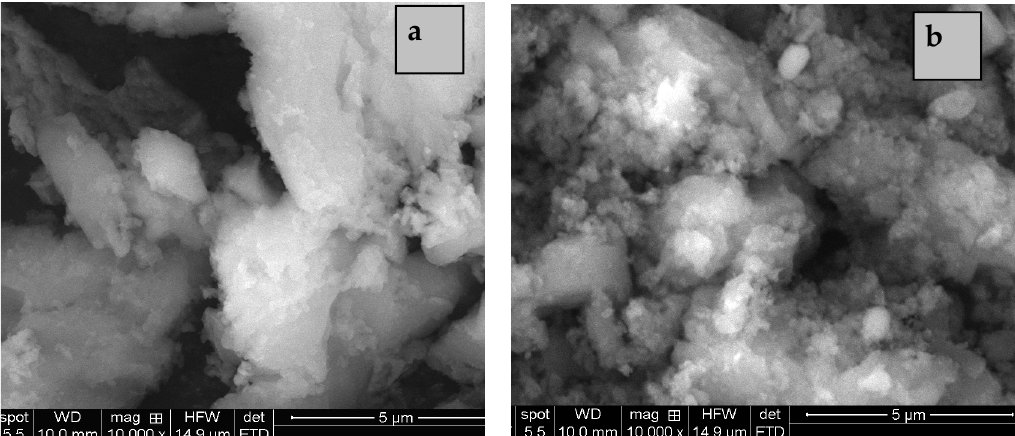
Membranes 2021 , 11 , x FOR PEER REVIEW Figure 2. SEM images of KIT-6 mesoporous silica hydrothermal treated at 80 °C ( a ) and 120 °C ( b ). Figure 2. SEM images of KIT-6 mesoporous silica hydrothermal treated at 80 ◦ C ( a ) and 120 ◦ C ( b ).